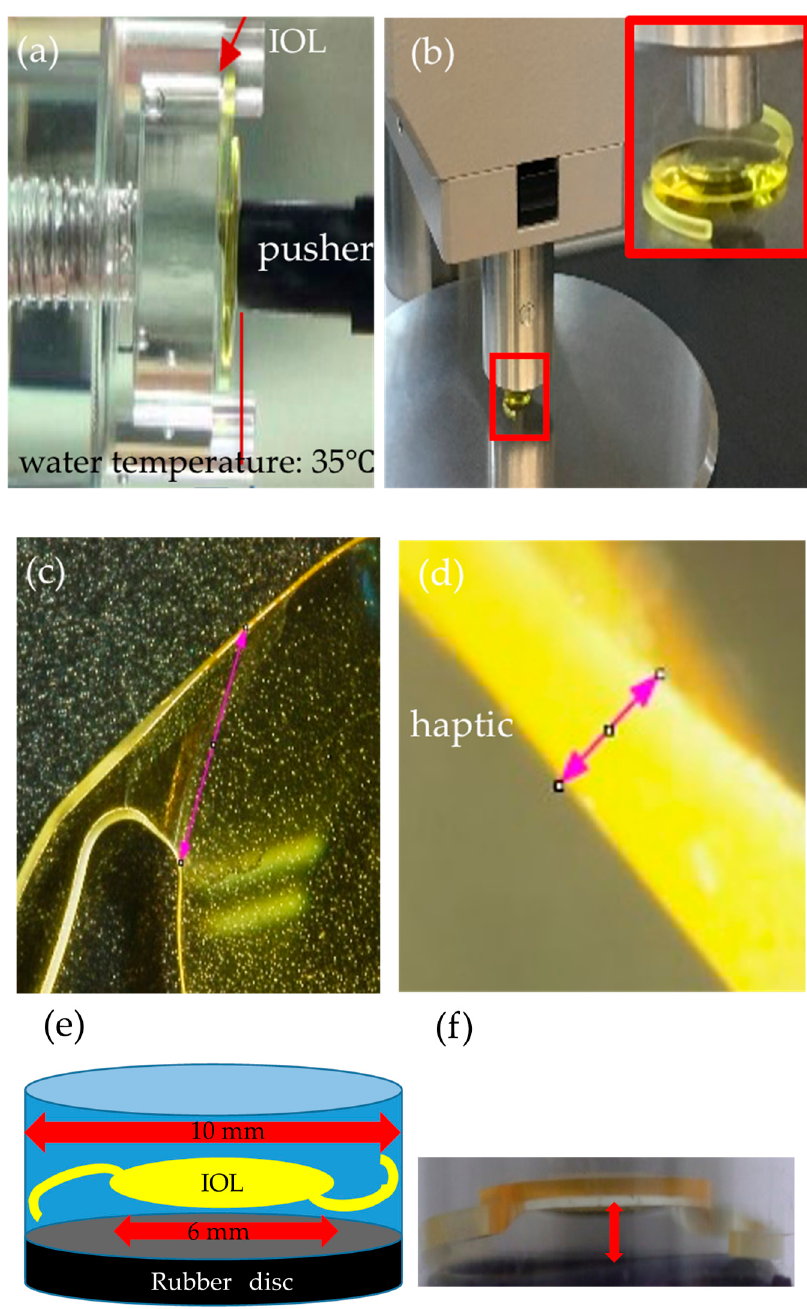
Figure 2. Experimental settings. ( a ) Setting for the IOL displacement force measurement. The forces required for anterior displacement of the IOLs. The IOLs set in the fixture are displaced anteriorly (anterior chamber side) by a pusher from the posterior (vitreous cavity) side until the IOL optics move 1 mm in the water. The water temperature is set at 35 ◦ C. ( b ) The setting for the IOL hardness measurement. The IOL is indented by the indenter perpendicular to the center of the optics. ( c , d ) The settings for the string lengths ( c , pink double arrow) and thickness ( d , pink double arrow) measurements of the haptics / optics junction area. ( e , f ) The settings for the posterior IOL bulge measurement. The IOLs are set in a clear cylinder with an inner diameter of 10 mm ( e ), and the distance between the rubber disc surface and surface of the IOL (red double arrow) is measured.